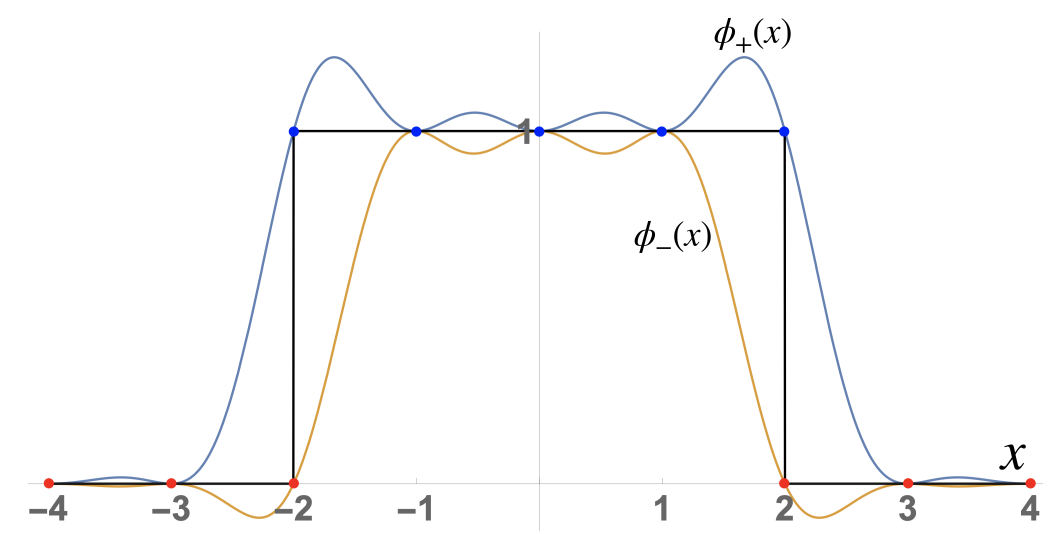
Figure 1: Functions φ ± ( x ) majorising and minorising the indicator function of the interval [ − 2,2 ]